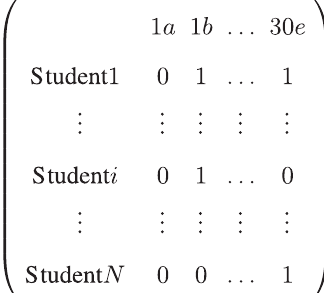
FIG. 1. The raw data are initially stored in a 143 × 150 matrix because our data set included 143 students and 150 response items.